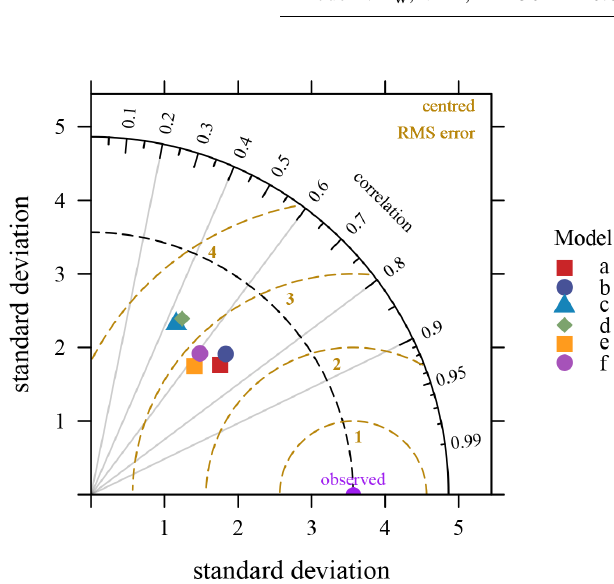
Figure 6. A Taylor diagram summarising the statistical compar- isons between the modelled NH 3 fluxes from the six models a–f described in the text and the measured NH 3